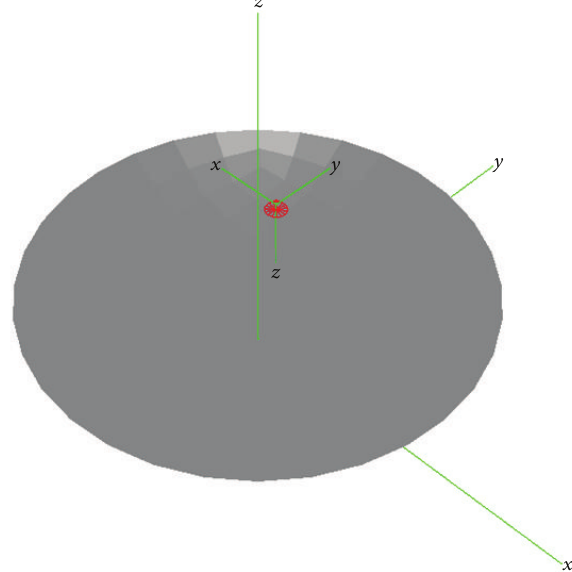
Figure 19: Single reflector with the horn